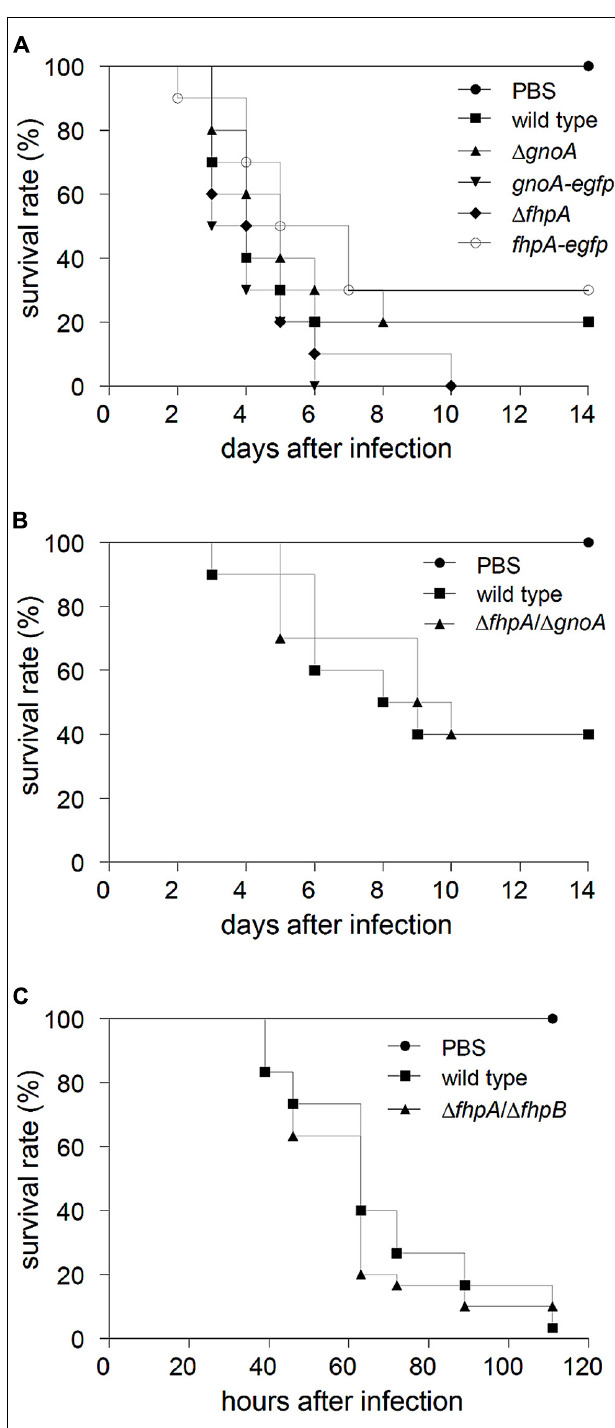
FIGURE 5 |Virulence studies. (A) Cortisone acetate treated mice were infected with 2 × 10 5 conidia of the indicated A. fumigatus strains. As control, a group of mice ( n = 5) remained uninfected (inhalation of PBS). Survival was monitored for 14 days. (B) Neutropenic mice were infected with 3 × 10 4 conidia of the indicated A. fumigatus strains. (C) Fresh larvae of the greater wax moth G. mellonella were infected with 5 × 10 5 conidia of the wild type and the (cid:2) fhpA / (cid:2) fhpB mutant, respectively. As mock control PBS was used. Survival of larvae was monitored for 5